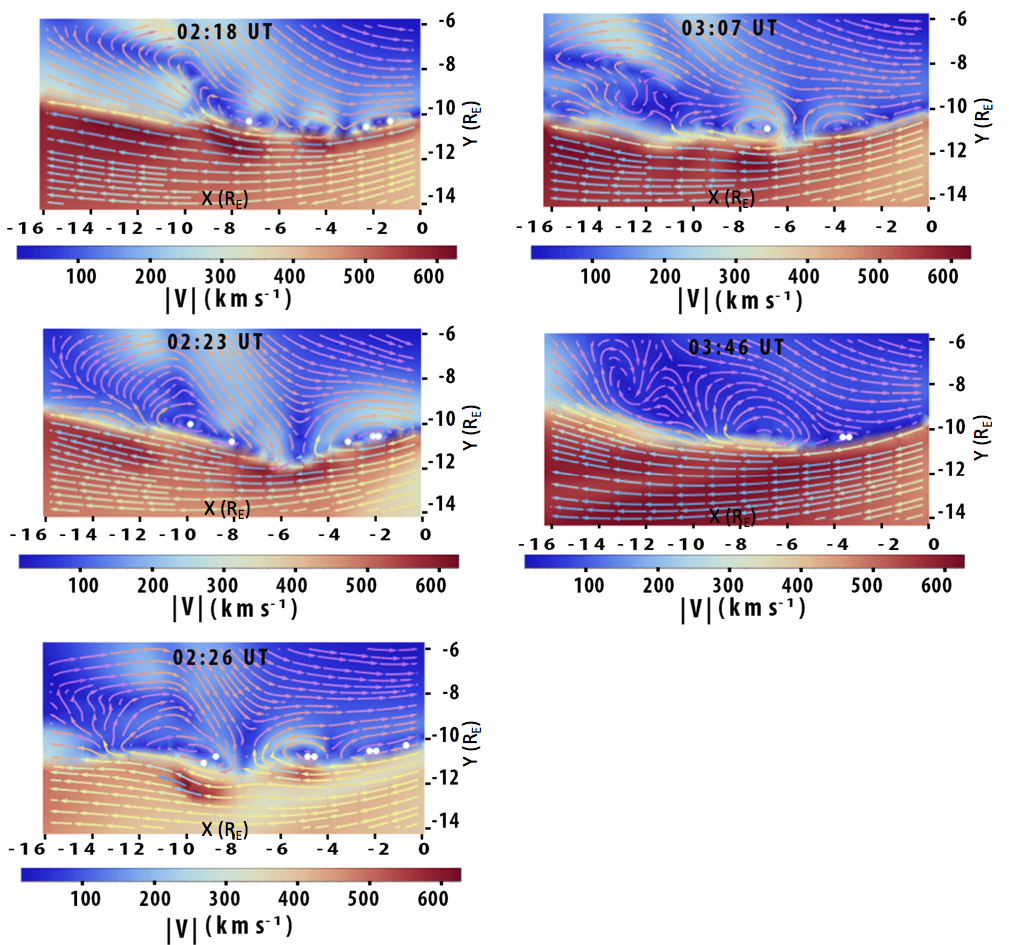
Figure 4. The white dots mark where the vortex centers were found using our VIA and they are visualized using Mathematica software for the same time steps as shown in Fig. 2. The colors represent velocity magnitude and the arrows indicate the flow direction.